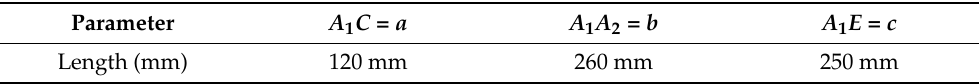
Table 1. Key linkage length.